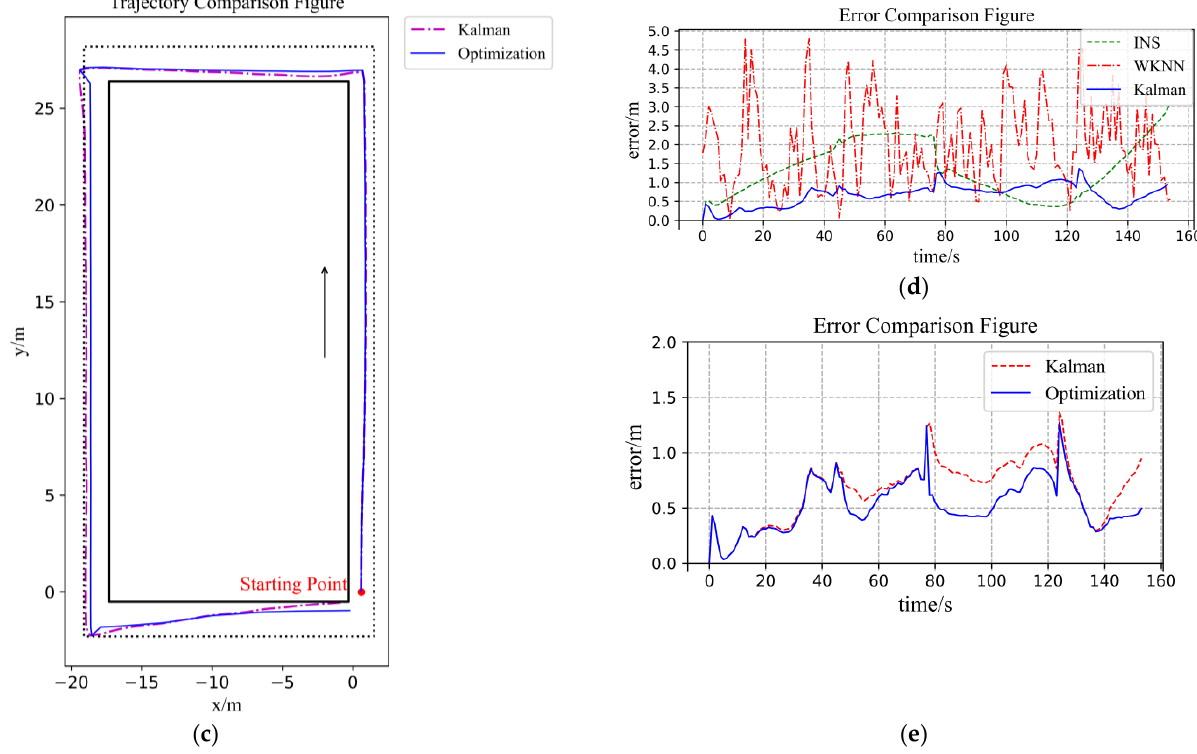
Figure 9. Figures of ESKF-based and constrained ESKF experiment results and comparison figures: ( a ) Figure of IMU-based and ESKF positioning trajectory comparison; ( b ) Figure of WiFi-based and ESKF positioning trajectory comparison; ( c ) Figure of ESKF and constrained ESKF positioning trajectory comparison; ( d ) Error figure of three positioning methods; ( e ) Error figure of data fusion method and optimization positioning method. Table 3. Comparisons of errors of three algorithms.